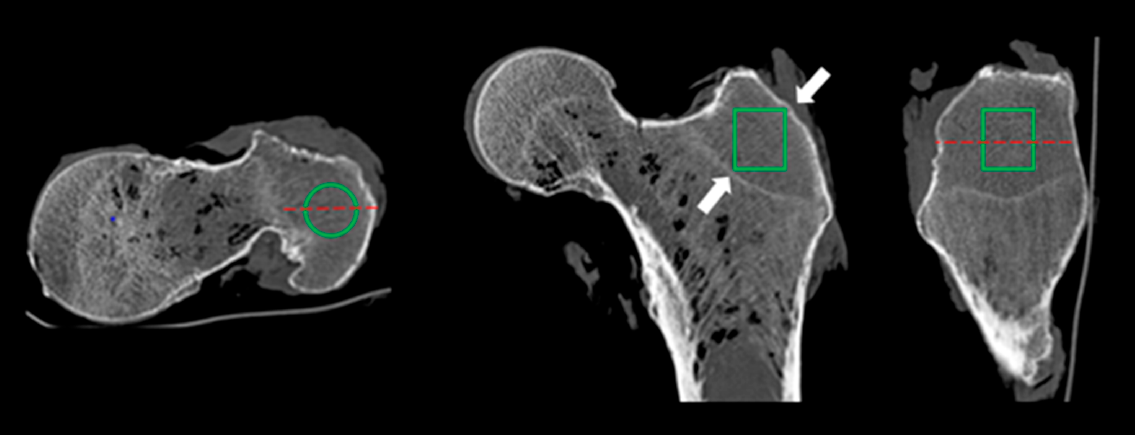
Figure 2. Example of great trochanteric CT cylindric VOI. The VOI is placed from top to bottom in the middle of a line joining external cortical bone and physis line and a line joining anterior and posterior cortex (red dashed lines). The placement avoided the inclusion of cortical bone and physis line in the VOI (white arrows).